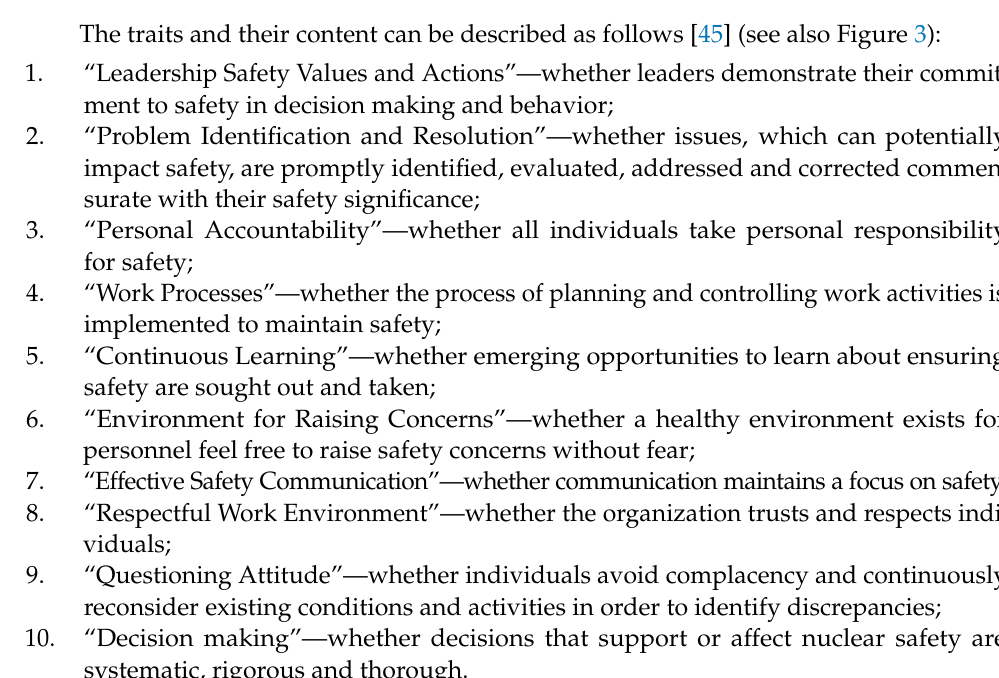
Figure 3. “10 Traits” reference framework integrated in the safety culture implemented in the organization structure .